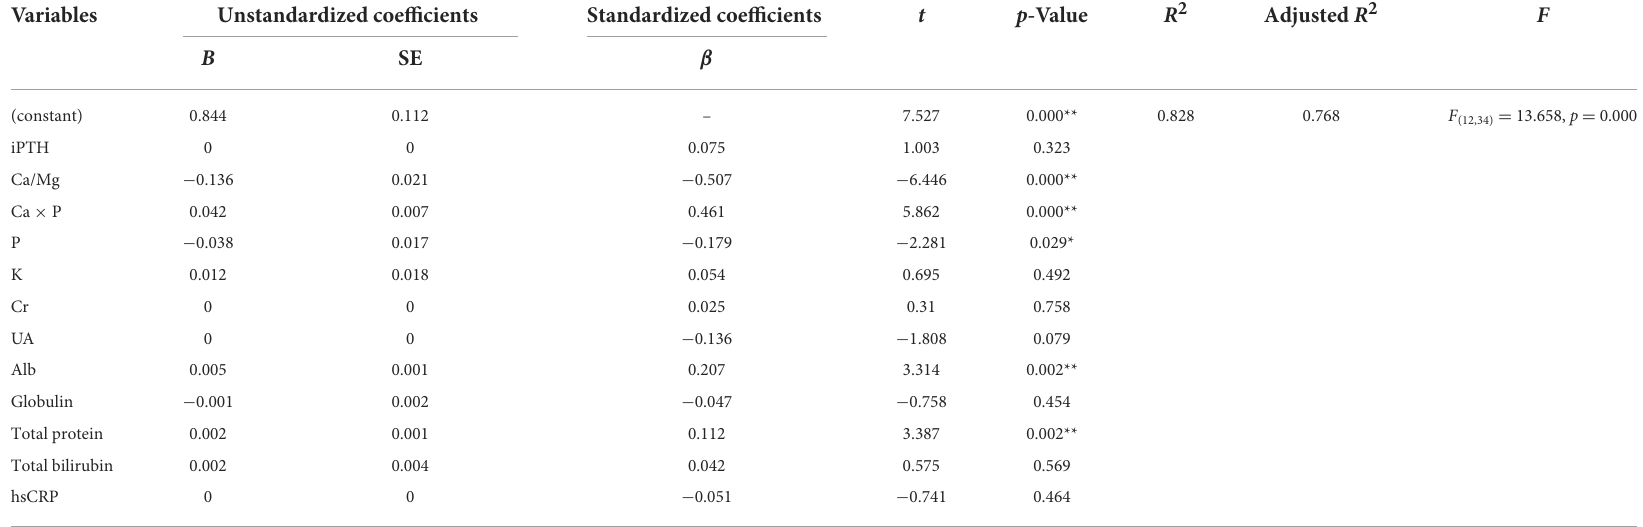
TABLE 5 Results of Ridge regression analysis in 398 PD